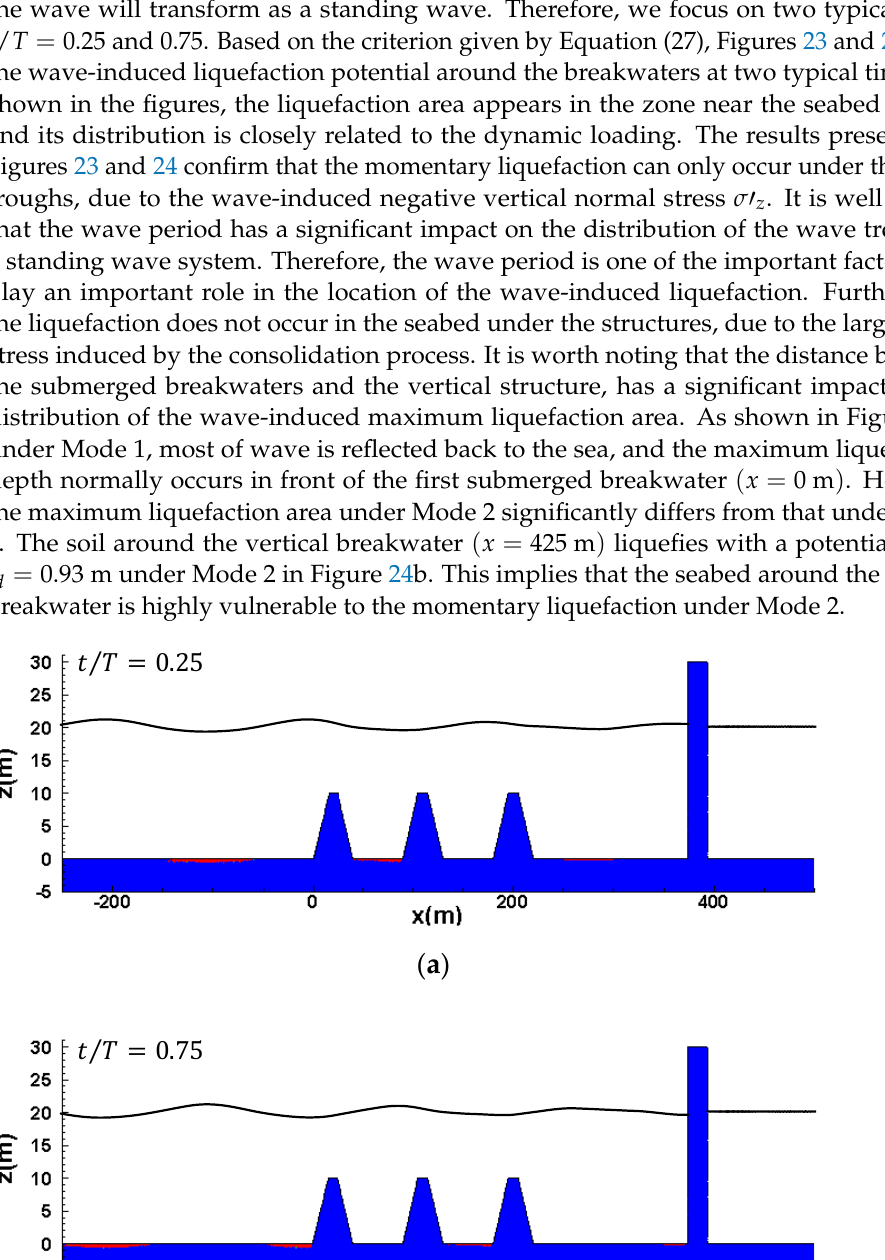
Figure 23. Distribution of the wave−induced liquefaction zone around the breakwaters with a period of 𝑘𝑑 = 0.6 under Mode 1 (at 𝑆 𝐿⁄ = 0.75 ). ( a ) 𝑡 𝑇⁄ = 0.25 ; ( b ) 𝑡 𝑇⁄ = 0.75 .